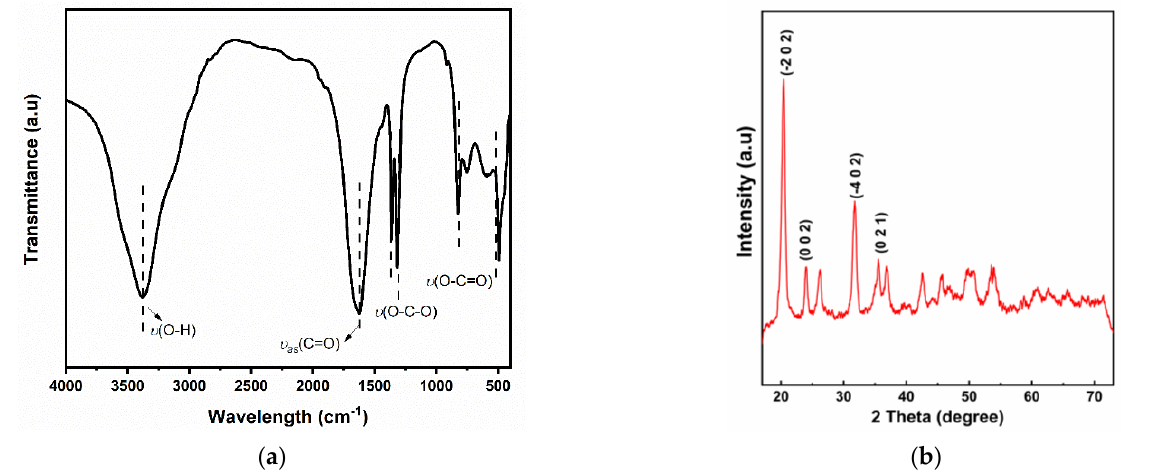
Figure 1. (a) FTIR Spectra and (b) X-ray diffraction spectra of ZnO precursor (zinc oxalate). Figure 1. ( a ) FTIR Spectra and ( b ) X-ray diffraction spectra of ZnO precursor (zinc